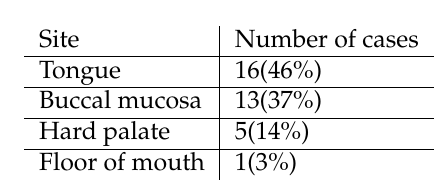
Table 2. Various sites of oral squamous cell carcinoma